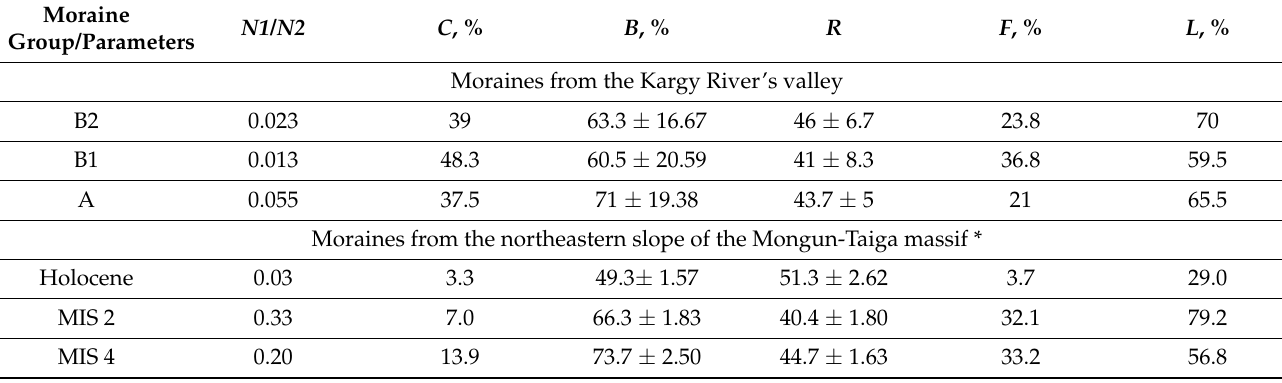
Table 2. Comparison of the relative dating results for the Kargy River’s valley and the Mongun-Taiga massif. Moraine N1/N2 C , % B , % R F , % L , % Group/Parameters Moraines from the Kargy River’s valley B2 0.023 39 B1 0.013 48.3 A 0.055 37.5 Moraines from the northeastern slope of the Mongun-Taiga massif * Holocene 0.03 3.3 MIS 2 0.33 MIS 4